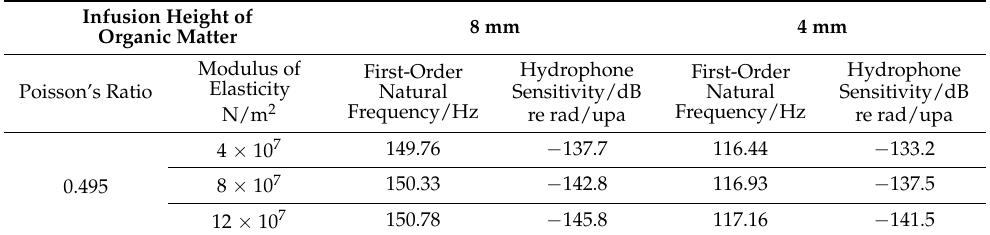
Table 1. Influence of physical parameters of polyurethane on hydrophone response.